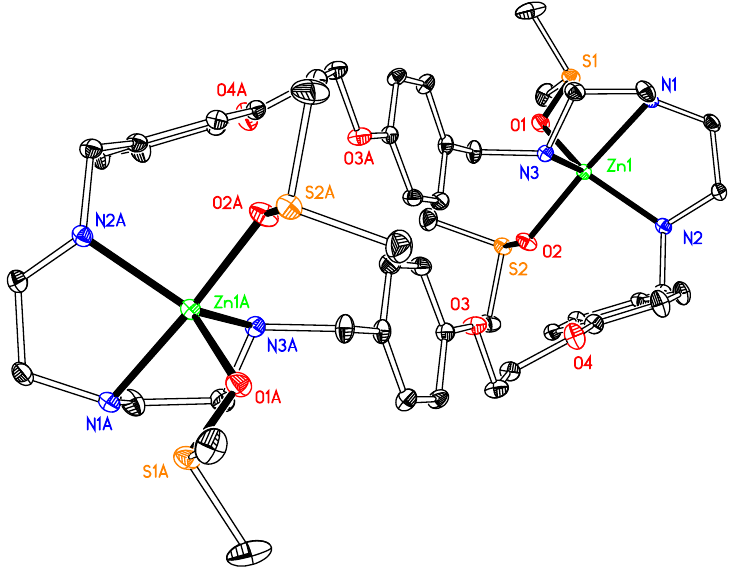
Figure 1. Thermal ellipsoid plot, drawn at the 50% probability level, of [Zn 2 (OS(CH 3 ) 2 ) 4 L 1 ] 4+ ( 1 ) with atomic numbering scheme. All H atoms and the counterions are omitted for clarity. Symmetry codes: A 1 − x, − y, − z. Selected bond lengths (Å) and angles ( ◦ ): Zn1-N1 2.1484(18), Zn1-N2 2.084(2), Zn1-N3 2.0922(18), Zn1-O1 2.0399(17), Zn1-O2 2.0556(16); N1-Zn1-N2 83.01(6), N2-Zn1-N3118.58(7), N1-Zn1-N3 84.43(7), O1-Zn1-O2 84.80(7).